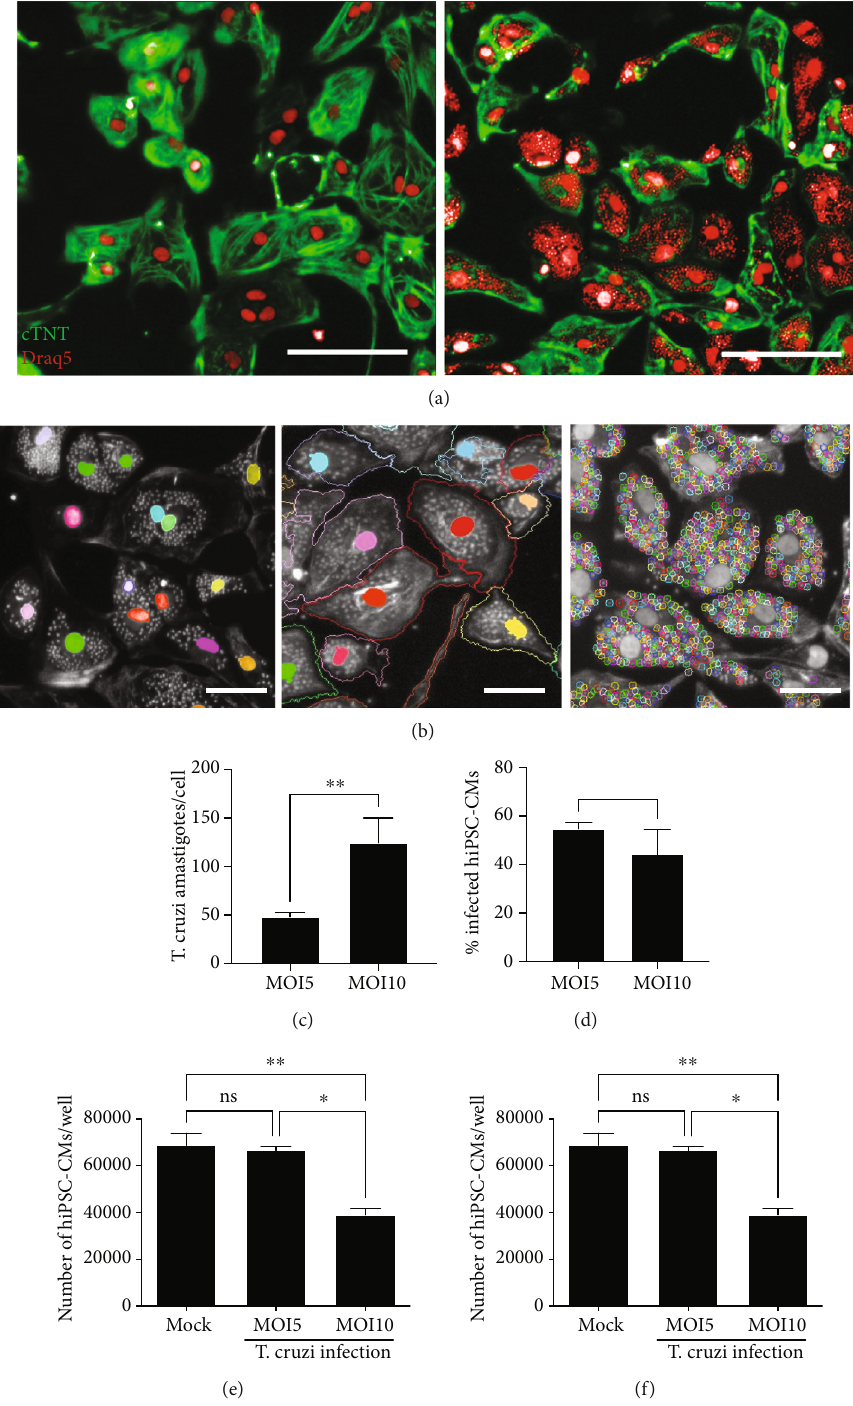
Figure 2: Infection of hiPSC-CMs with T. cruzi and high-content screening analysis. (a) Representative image of uninfected hiPSC-CM control, showing cTnT staining (green) and nuclei stained with Draq5 (red). (b) Representative image of hiPSC-CMs infected with T. cruzi , showing cTnT staining (green) nuclei and amastigotes stained with Draq5 (red). (c) Standardization of image analysis in Operetta High Content Imaging System, illustrating the steps of nuclei identi fi cation (left), followed by cytoplasm delimitation (middle), and T. cruzi amastigote spot identi fi cation (right). Quanti fi cation of the number of amastigotes/cell (d), percentage of infection (e), and number of hiPSC-CMs (f) 72 h following infection in MOI = 10 and MOI = 5 . ∗ p < 0 : 05 ; ∗∗ p < 0 : 01 ; ns = not significant ( p ≥ 0 : 05 ). Bars = 50 μ m